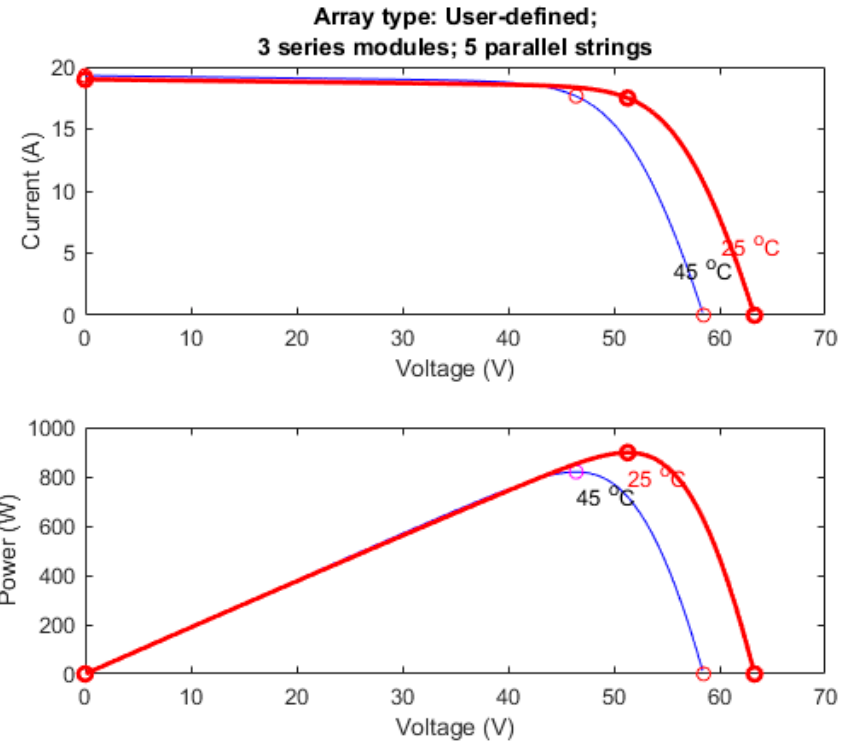
Figure 7. The I-V curves and the P-V curves for the PV array for the incident irradiance equal to 1 kW/m 2 and for two values of temperature: 25 °C and 45 °C, respectively.